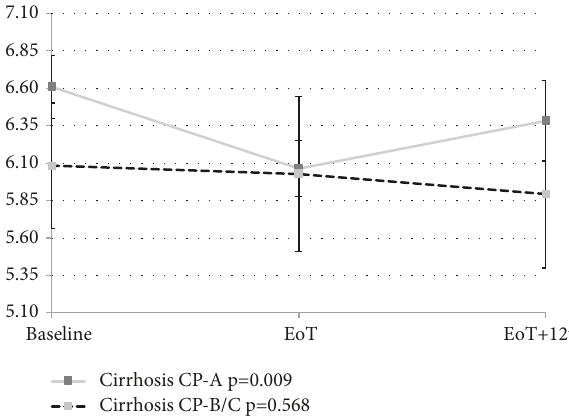
Figure 5: Changes of fasting glycemia with treatment in patients with Child-Pugh A and Child-Pugh B/C cirrhosis. EoT: end of treatment; EoT+12w: 12 weeks after the end of